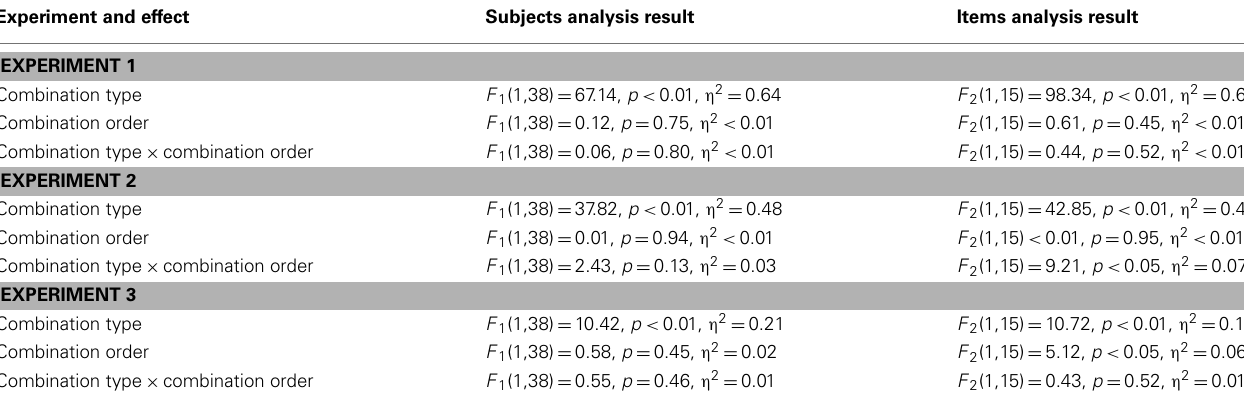
TableA1 |ANOVA by subjects and by items results for each of the three